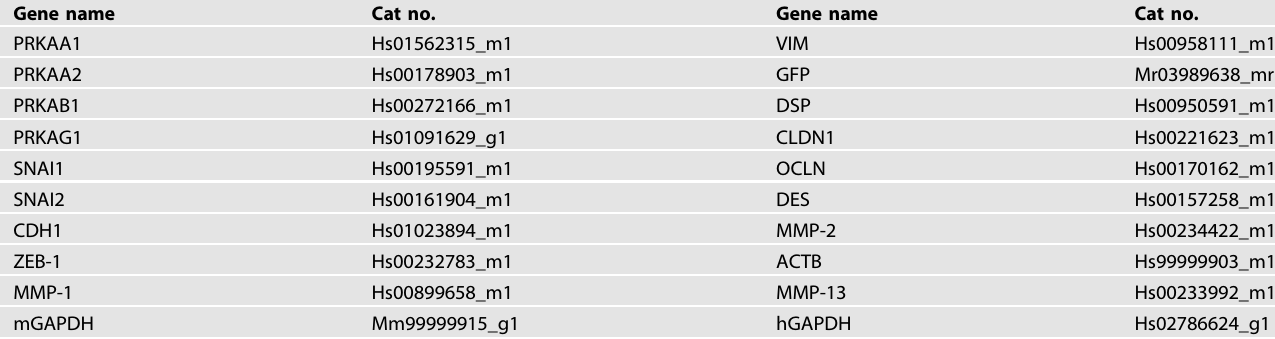
Table 1. Taq-Man qRT-PCR probes list. Gene